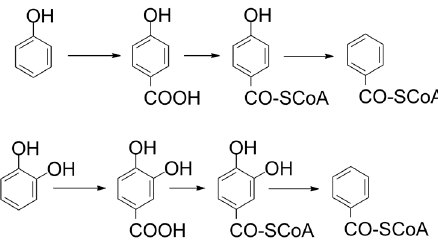
Figure 6. Examples of anaerobic carboxylation reactions of phenol and catechol.